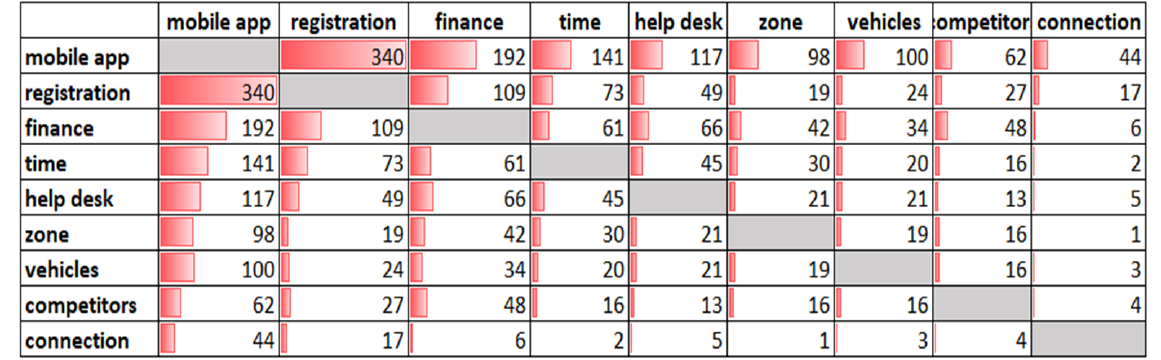
Figure 14. Co-occurrence of topics in comments.